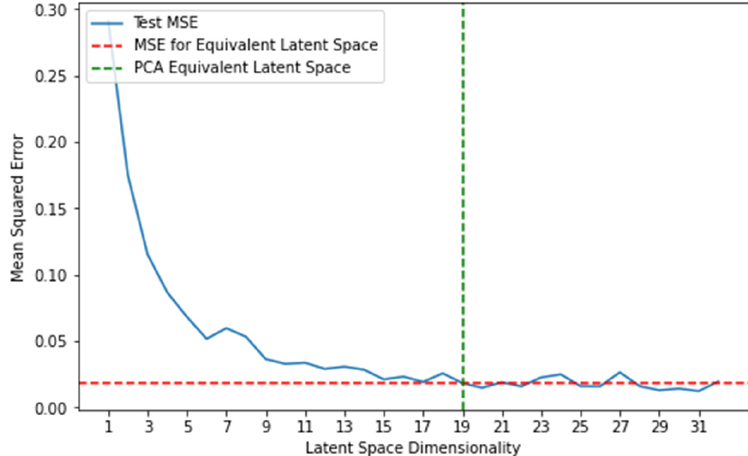
Figure 8. Reconstruction MSE for different latent space dimensionalities.